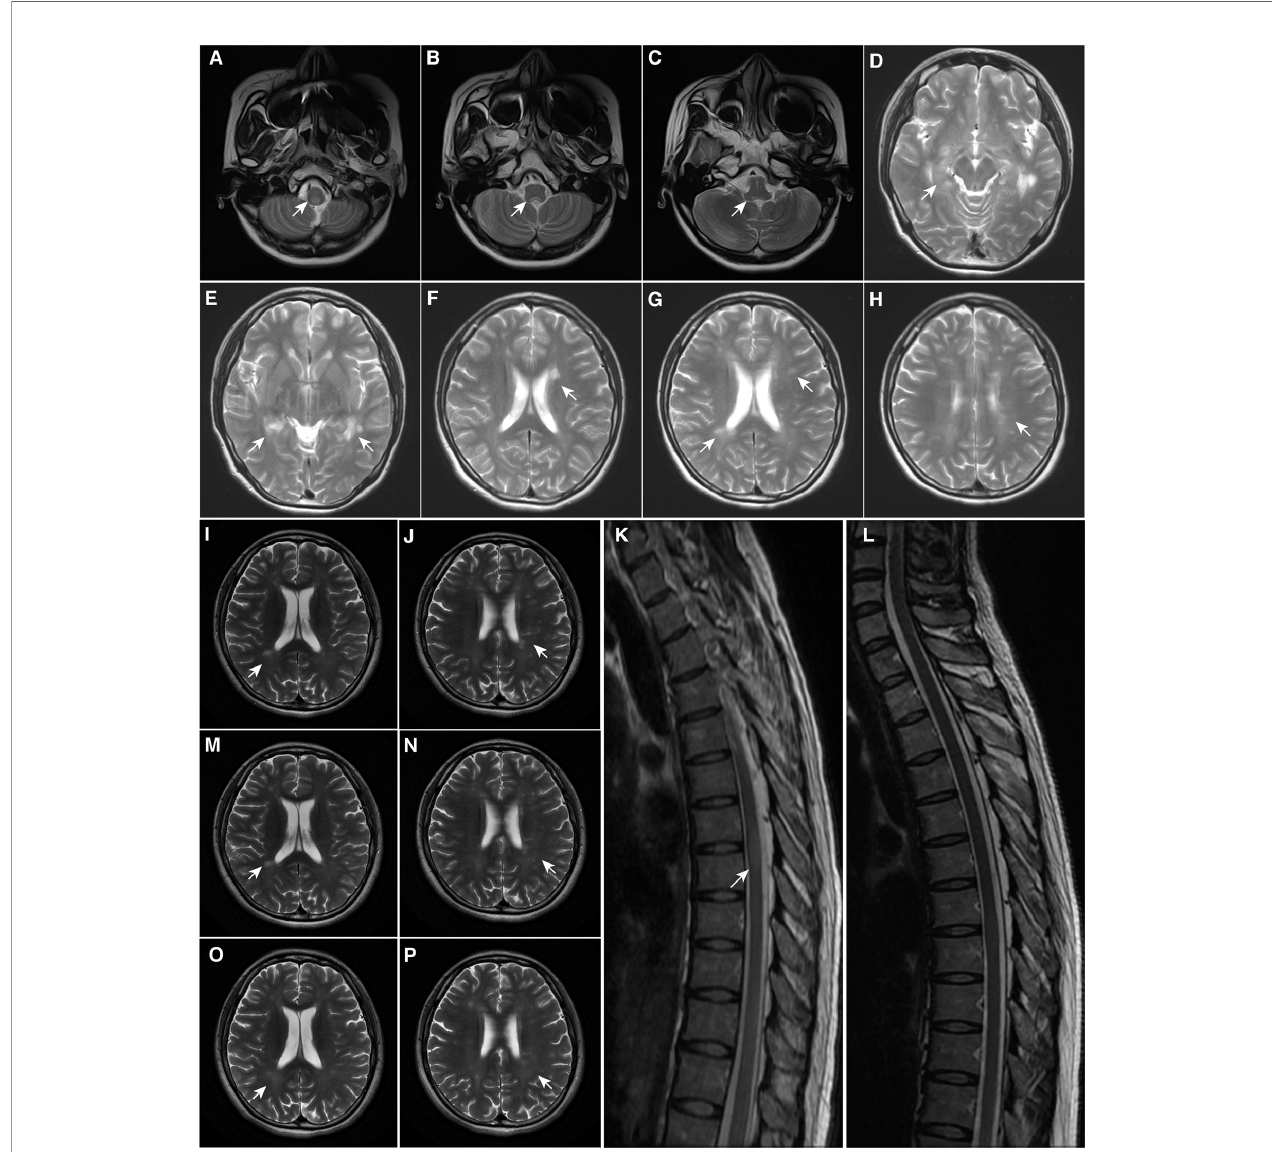
sclerosis; (I – K) Before teri fl unomide administration, MRI demonstrated new punctate enhancing lesions in the left frontal lobe and abnormal signals in the thoracic spinal cord at T6-7 of the skull and spinal cord; (L – N) After 6 months of teri fl unomide use, MRI demonstrated that the lesions were reduced, especially in the spinal cord; (O, P) After 1 year of teri fl unomide use, MRI demonstrated that the patient ’ s lesions were reduced. The arrowhead showing lesions in MRI. MRI, Magnetic resonance